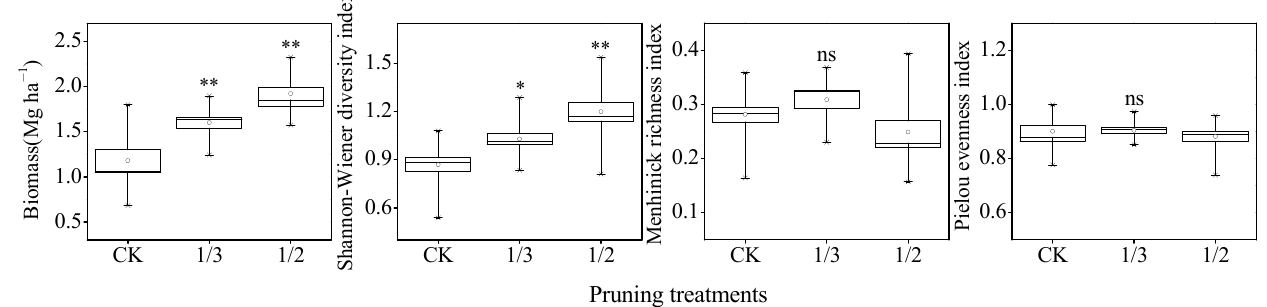
Figure 2. Effects of pruning on understory vegetation biomass, the Shannon–Weiner diversity index ( H’ ), Menhinick’s richness index ( Dm ) and Pielou’s evenness index ( Jsw ) in October 2018. Note: The box represents ± SE, the whiskers show the minimum and maximum, the small circle is the mean, and the horizontal line is the median. Statistically significant differences between pruning treatments and CK are indicated by symbols: ** p < 0.01, * p < 0.05 and ns—no significant difference.